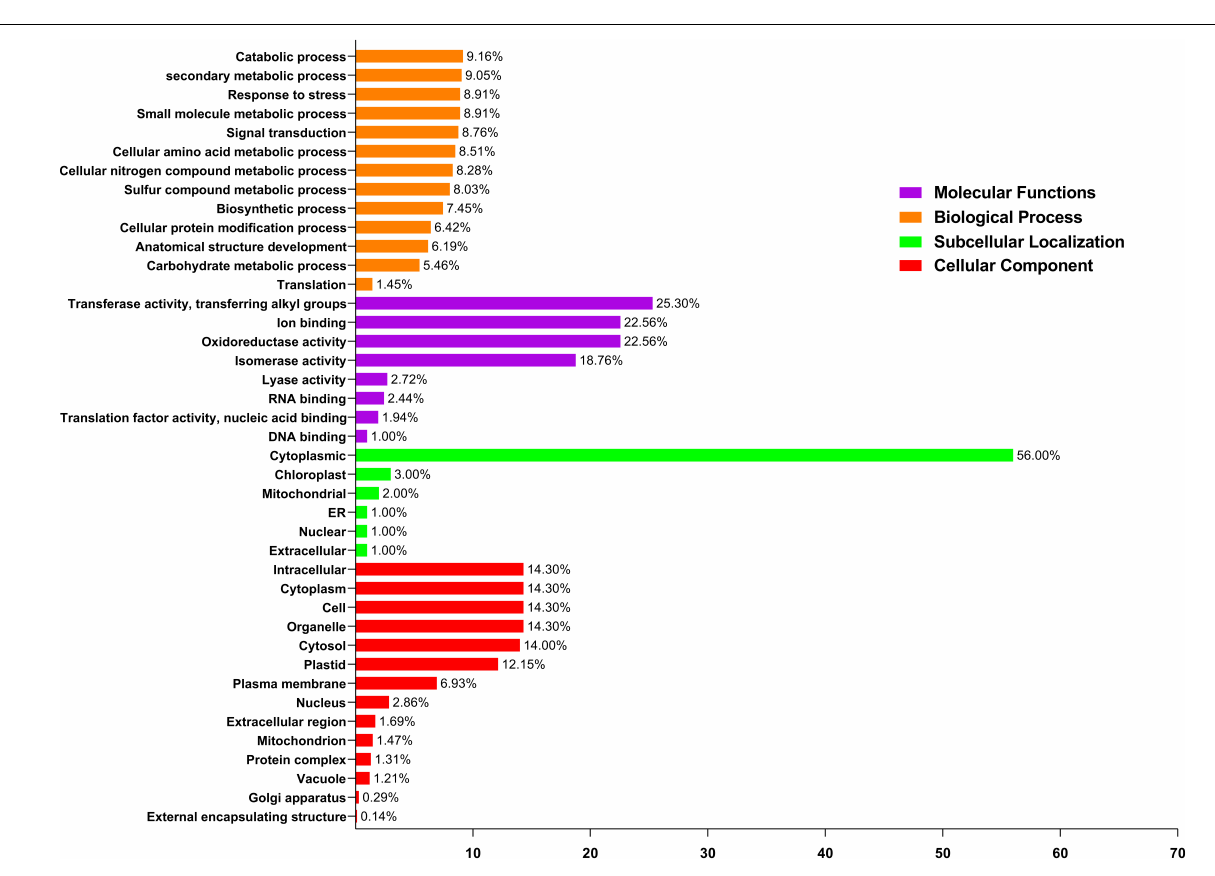
FIGURE 8 | Gene ontology (GO) annotation of PavGST proteins. The GO annotation was performed based on three categories, Molecular function, cellular component, and biological process. The numbers on the bars represent the number of predicted